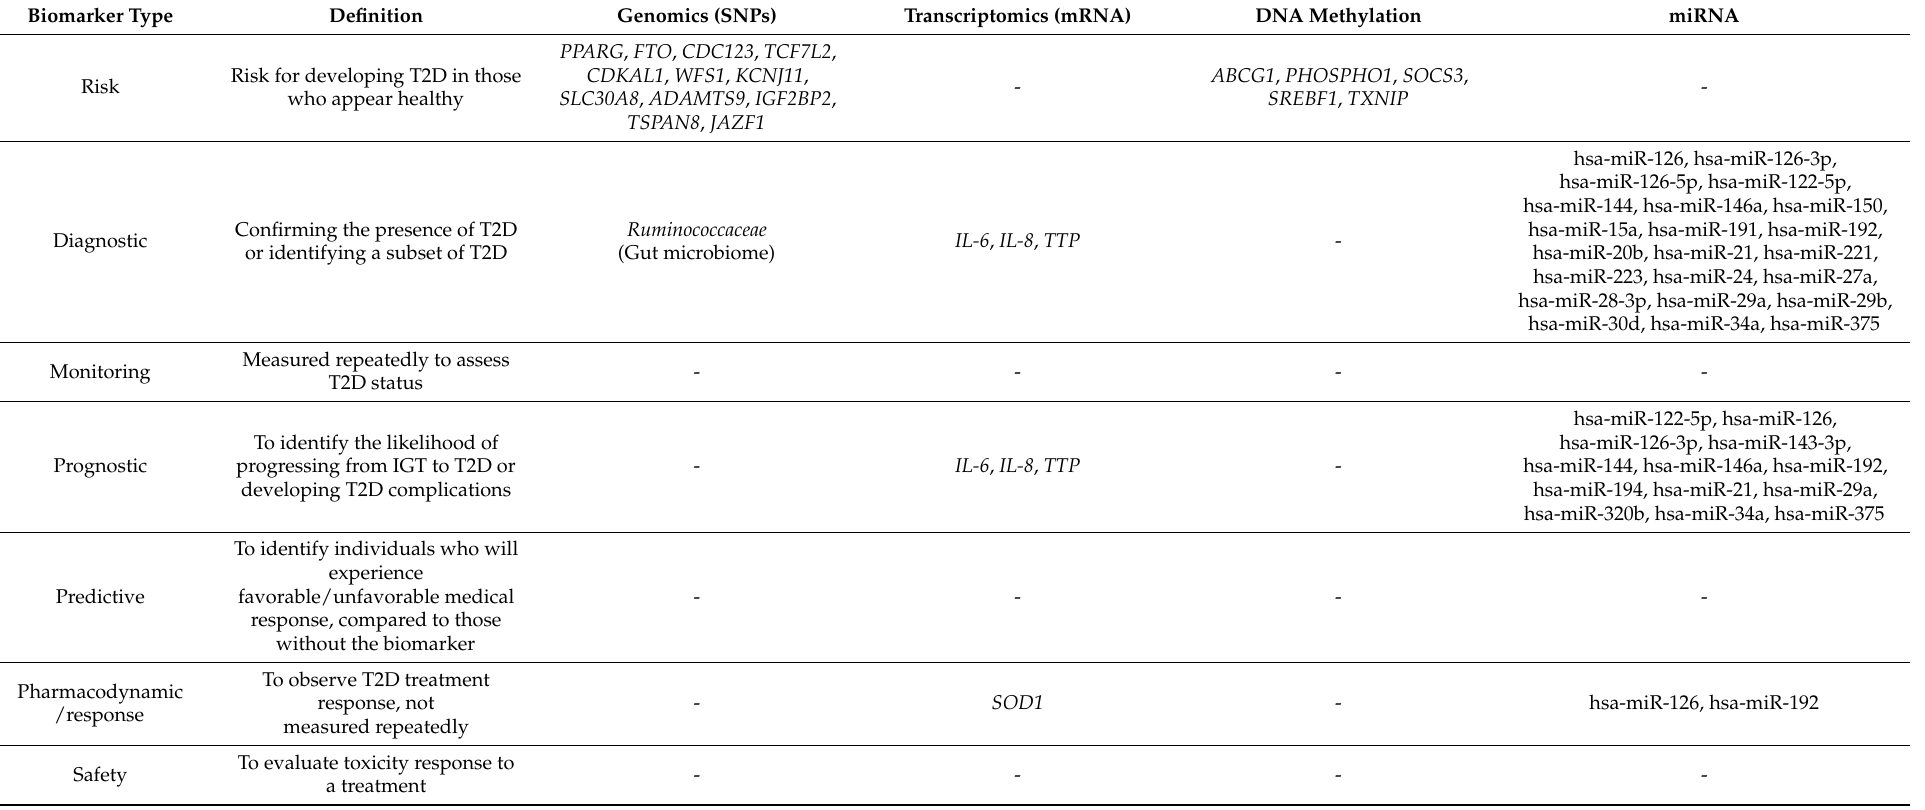
Table 11. Classification of potential genomics, transcriptomics, and epigenomics biomarkers of